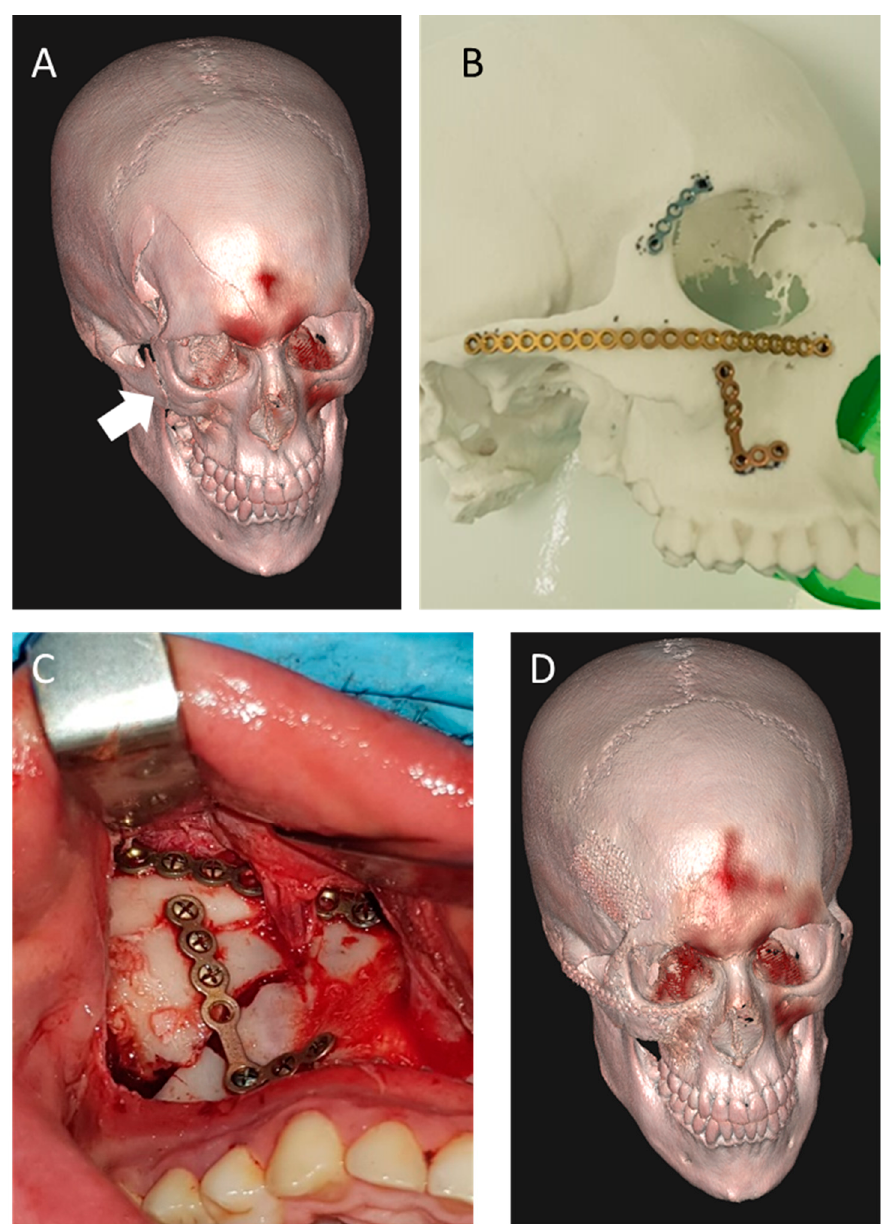
Figure 5. 3D design and printing for midface reconstruction. Volumetric representation of a zygomatic complex fracture (white arrow) is obtained, followed by mirroring and pre-bending reconstruction plates based on a 3D printed model ( A , B ). Intra-operative installation of pre-bent implants ( C ) and 3D visualization of the postoperative result ( D ).